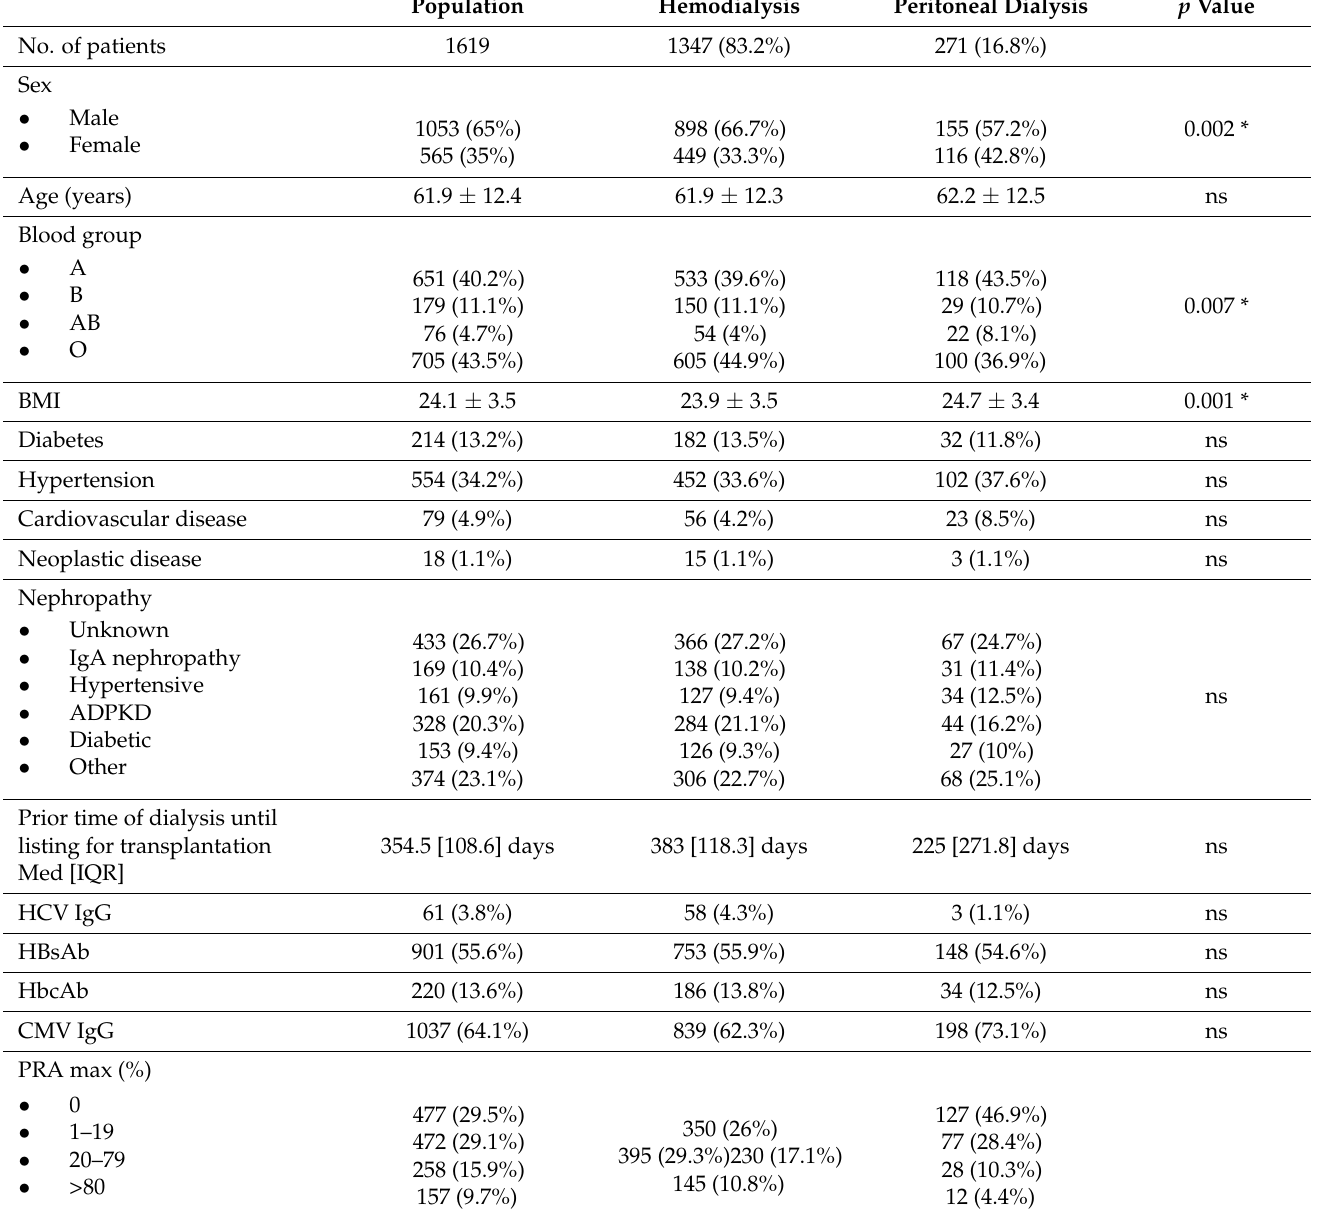
Table 1. Features of the study population and according to the type of